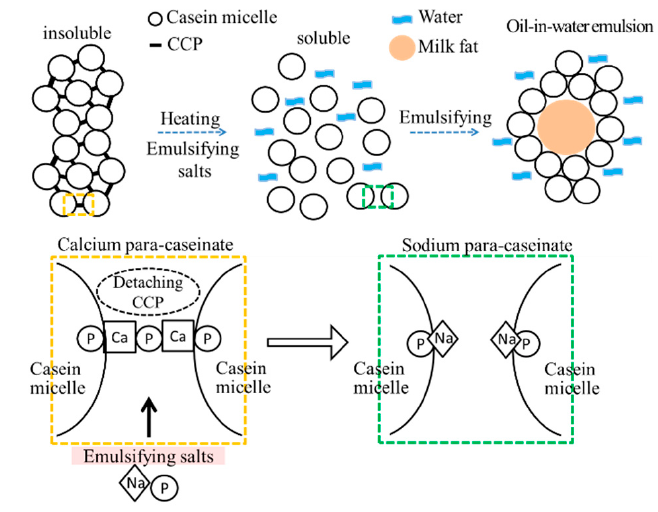
Figure 9. The mechanism by which emulsifying salts function on casein micelles.